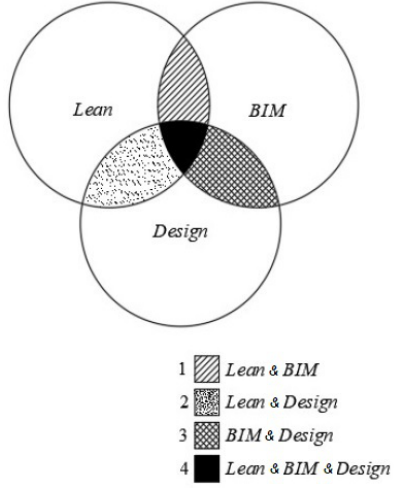
Figure 2. Theoretical